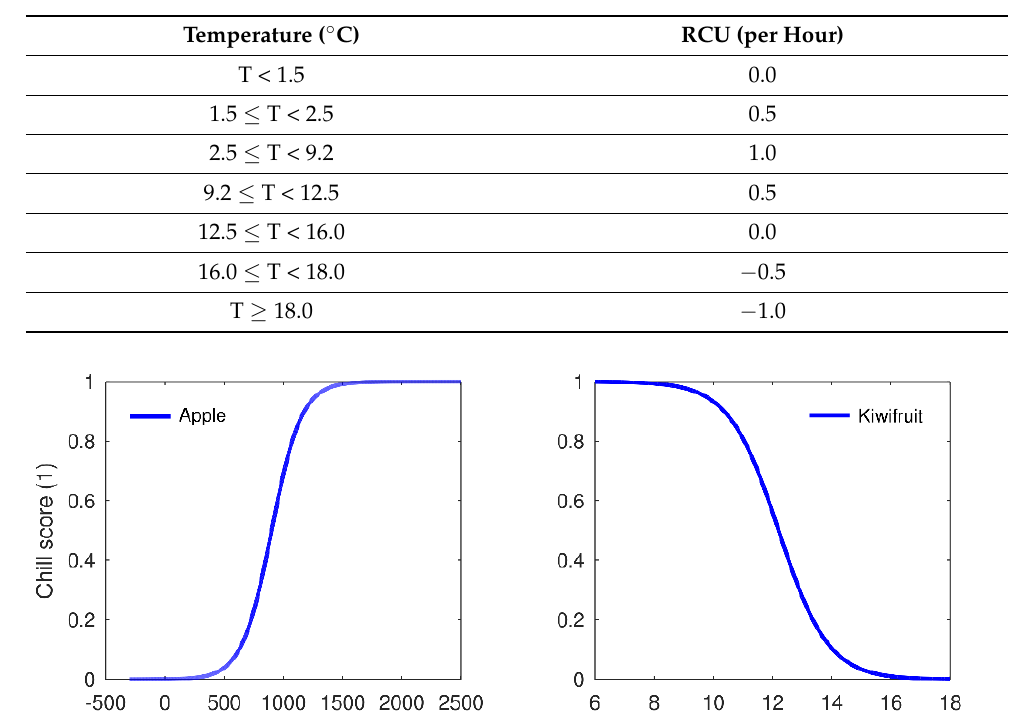
Table 2. Richardson Chill Units (RCU) assigned for different temperature ranges, sourced from